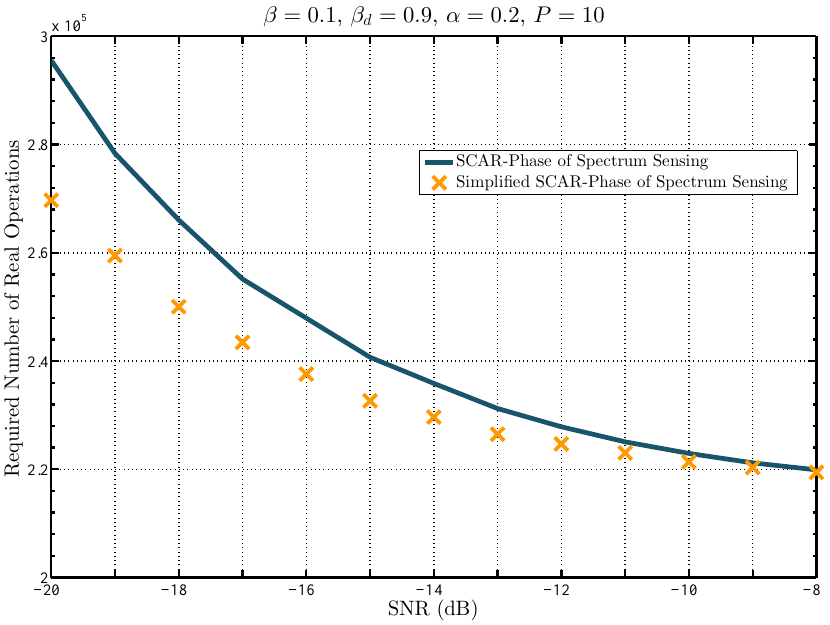
Figure 9. Comparison of the required number of real operations to achieve a probability of detection β d = 0.9 for a target probability of false alarm β = 0.1 for the proposed spectrum sensing